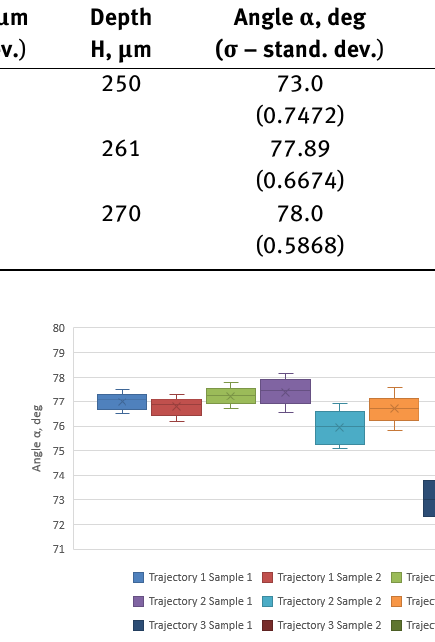
Figure 13: Statistical analysis of d1 diameter value measurements for all trajectories.